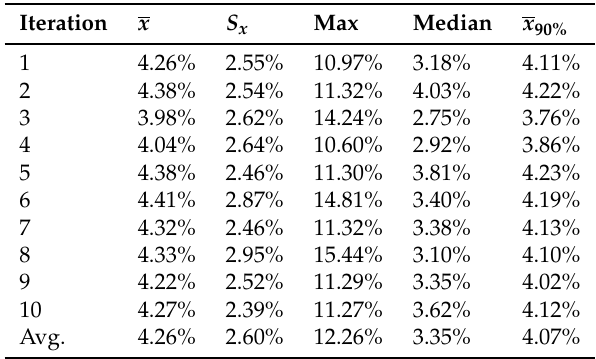
Table 2. Prediction deviation (as %) of the ultimate tensile